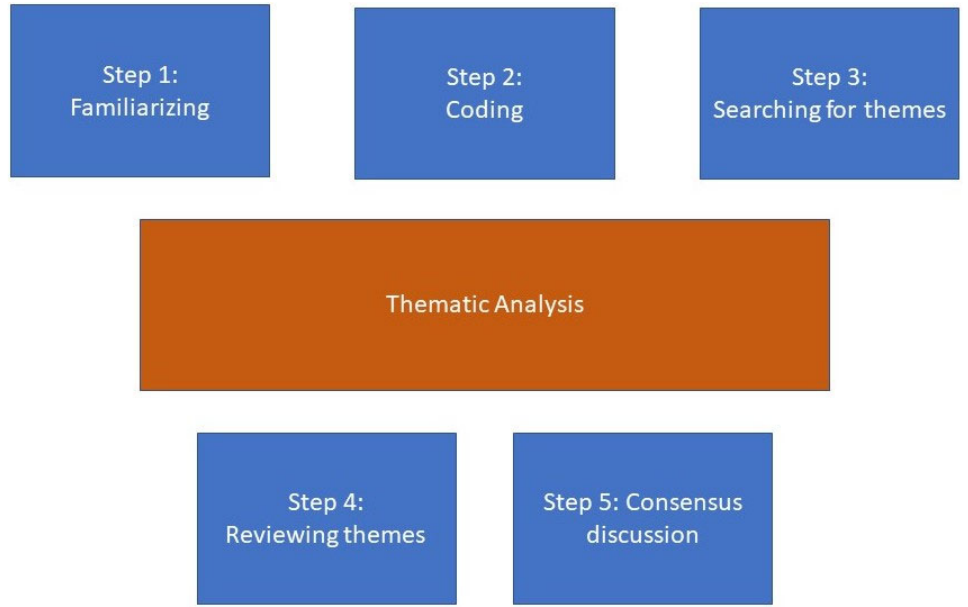
Figure 1. Stages of coding and analysis of the data.